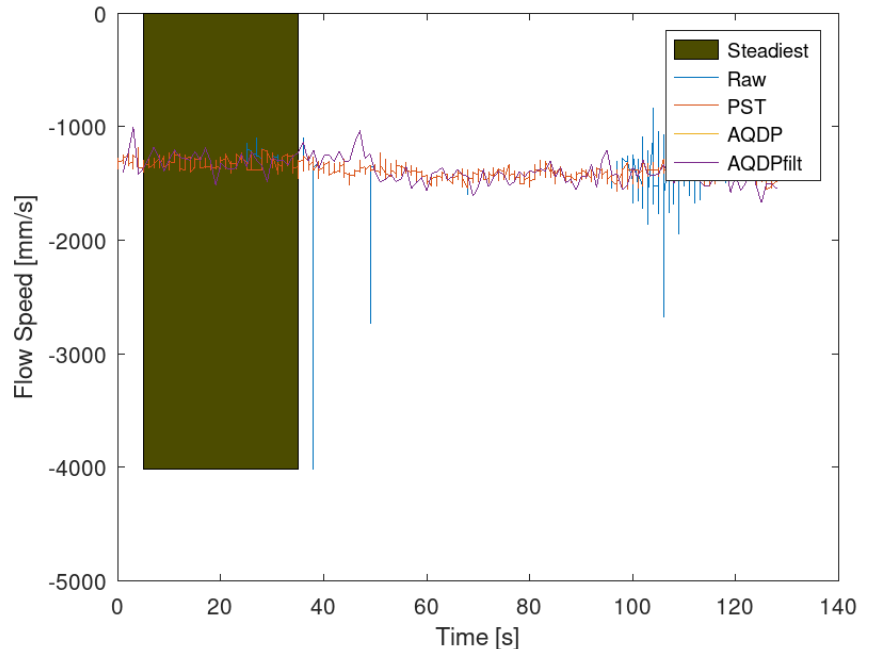
Figure A2. Example of an inflow data set. Raw and PST filtered Vector data. The selected steadiest 30 s section is highlighted. Raw and filtered Depth averaged flow velocity from Aquadopp sensor is also shown.